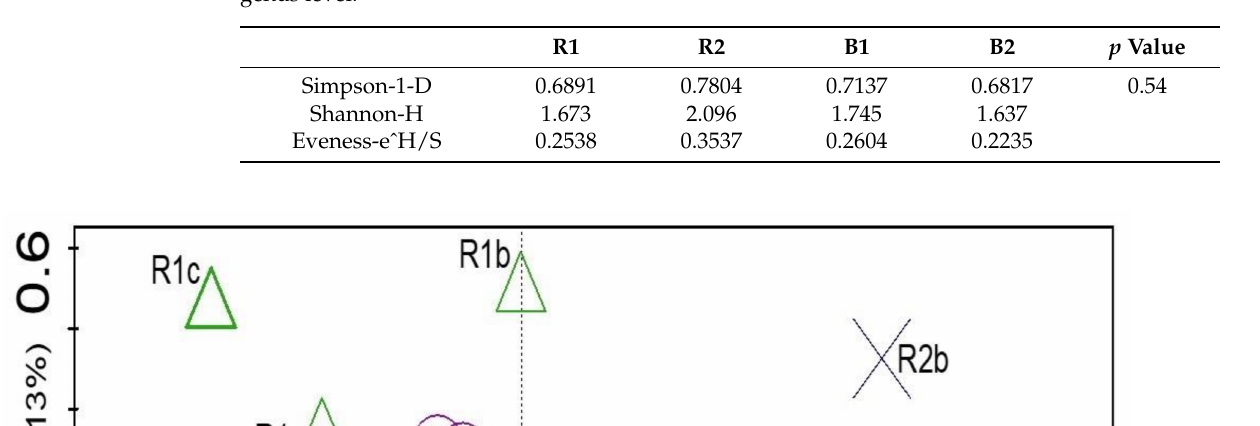
Table 2. Diversity indices indicating the Simpson, Shannon, and evenness of microorganism at the genus level.